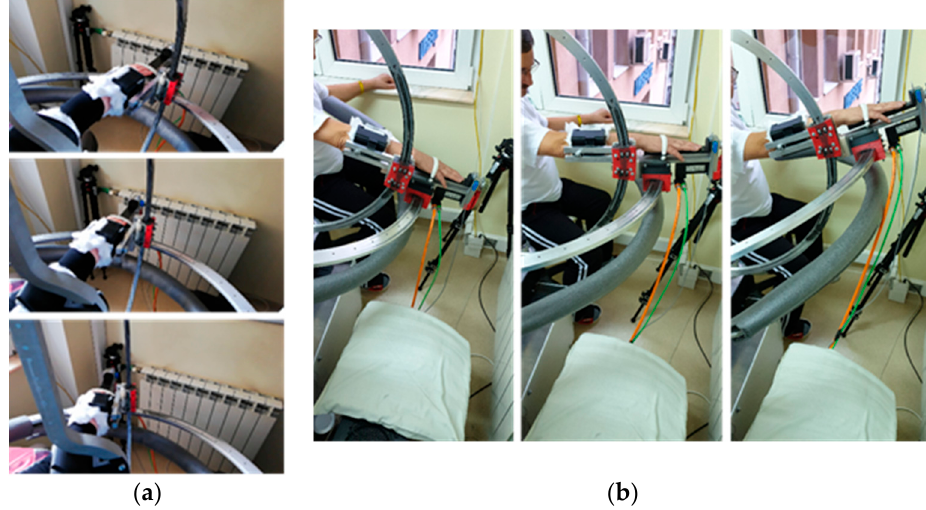
Figure 10. Snapshots from the experimental tests using ASPIRE: ( a ) flexion–extension motion and ( b ) adduction–abduction